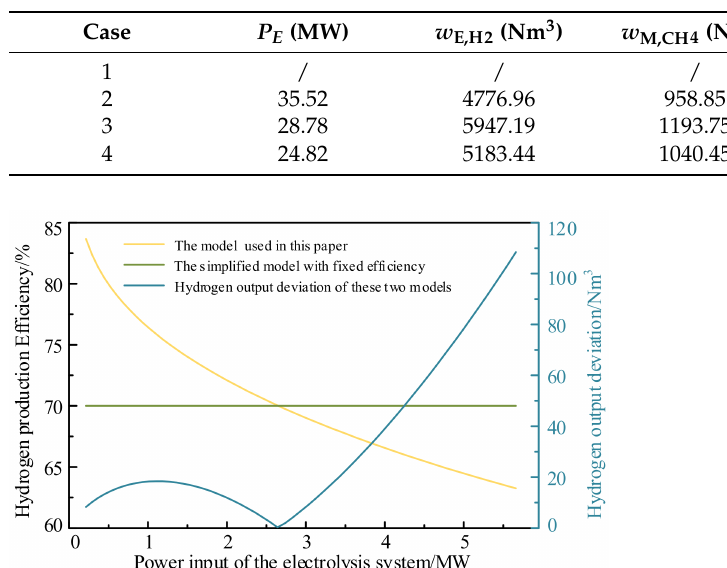
Table 4. Operation situations of a P2G system.